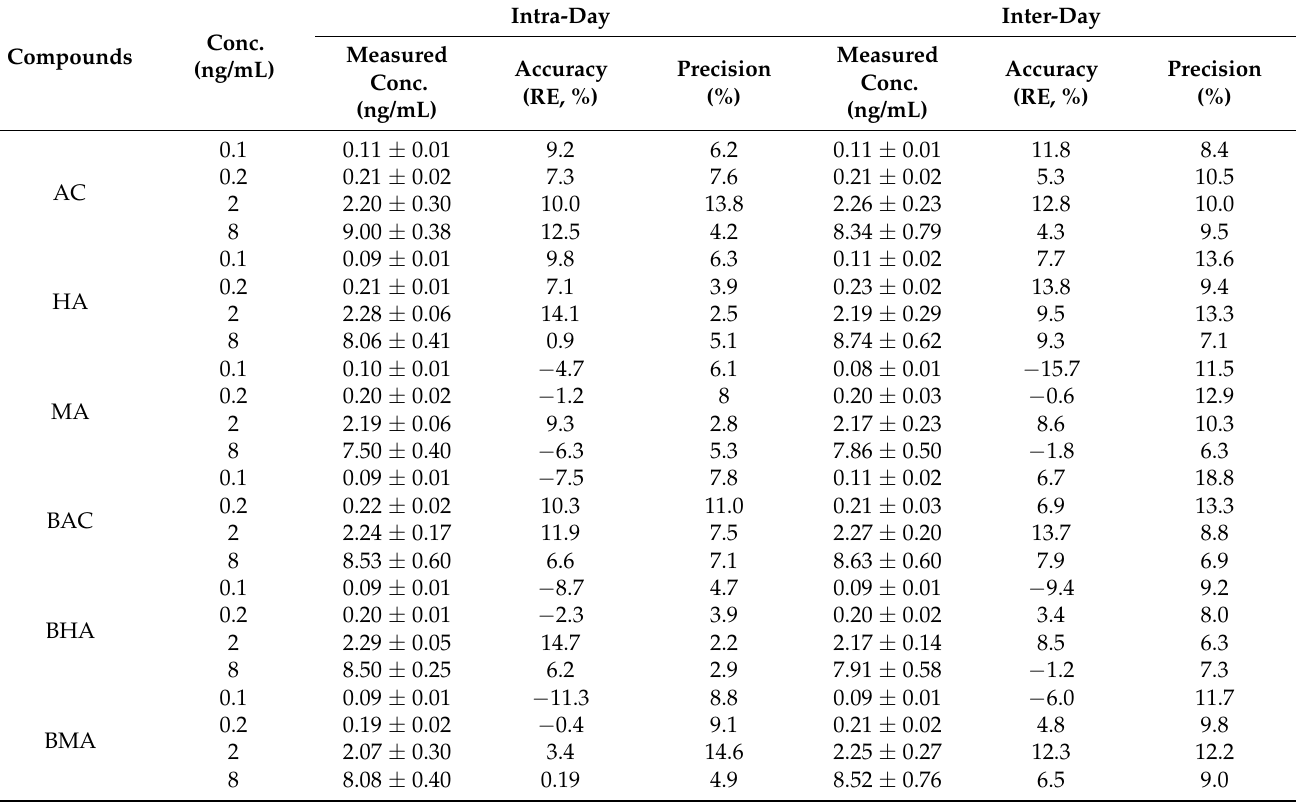
Table 2. Intra- and Inter-day precision and accuracy of the developed methods ( n =